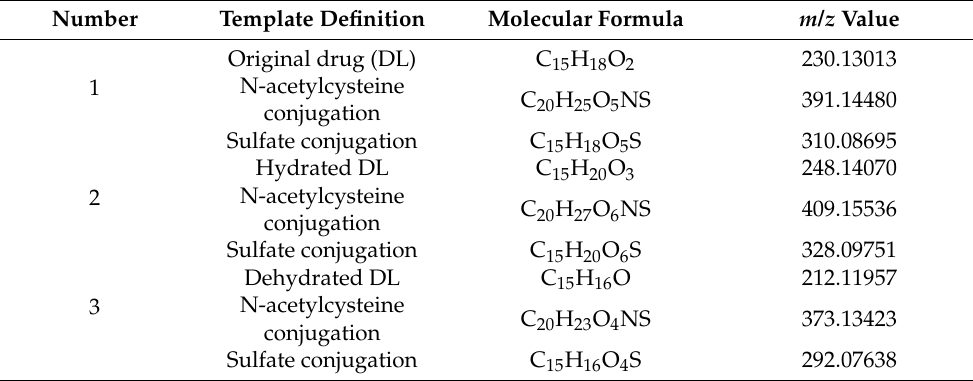
Table 1. The principal screening templates in the MMDF method.